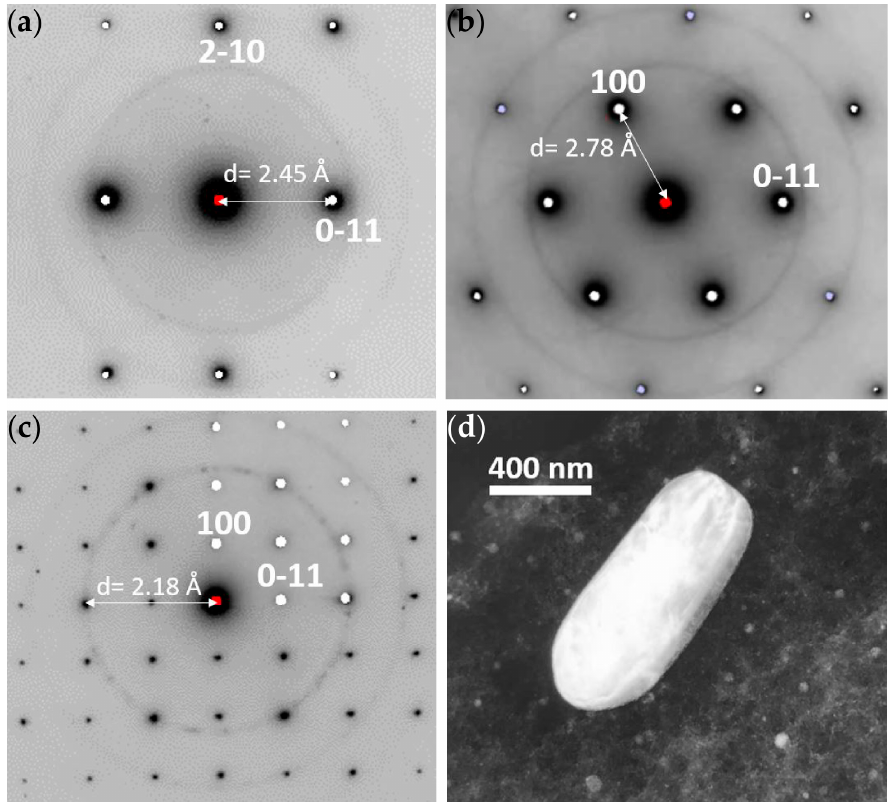
Figure 4. SAD images with overlaid simulated patterns of Mg depicted in the ( a ) [122] and ( b ) [011] ZA orientations; ( c ) SAD from the Al 11 Mn 5 particle depicted in ( d ) with confirming simulated pattern overlaid. The ring patterns in ( a – c ) are found to be consistent with MgO-precipitates.